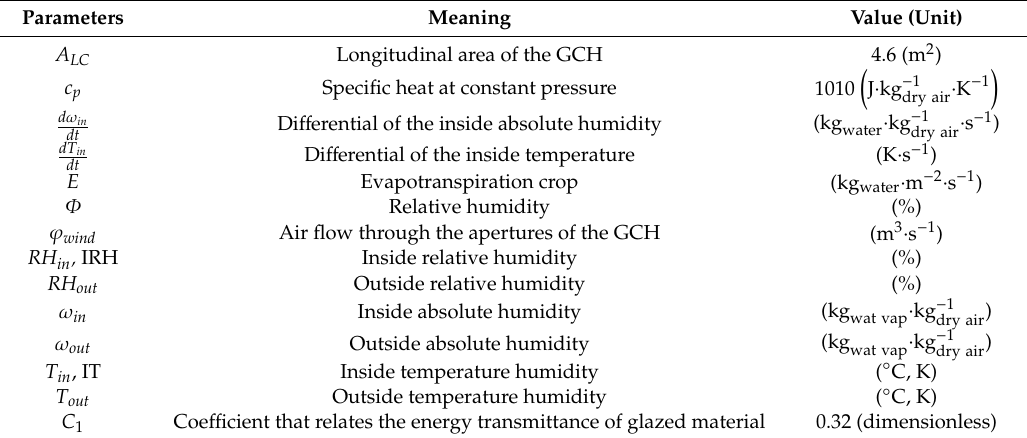
Table 1. Parameters used for the growth chamber model